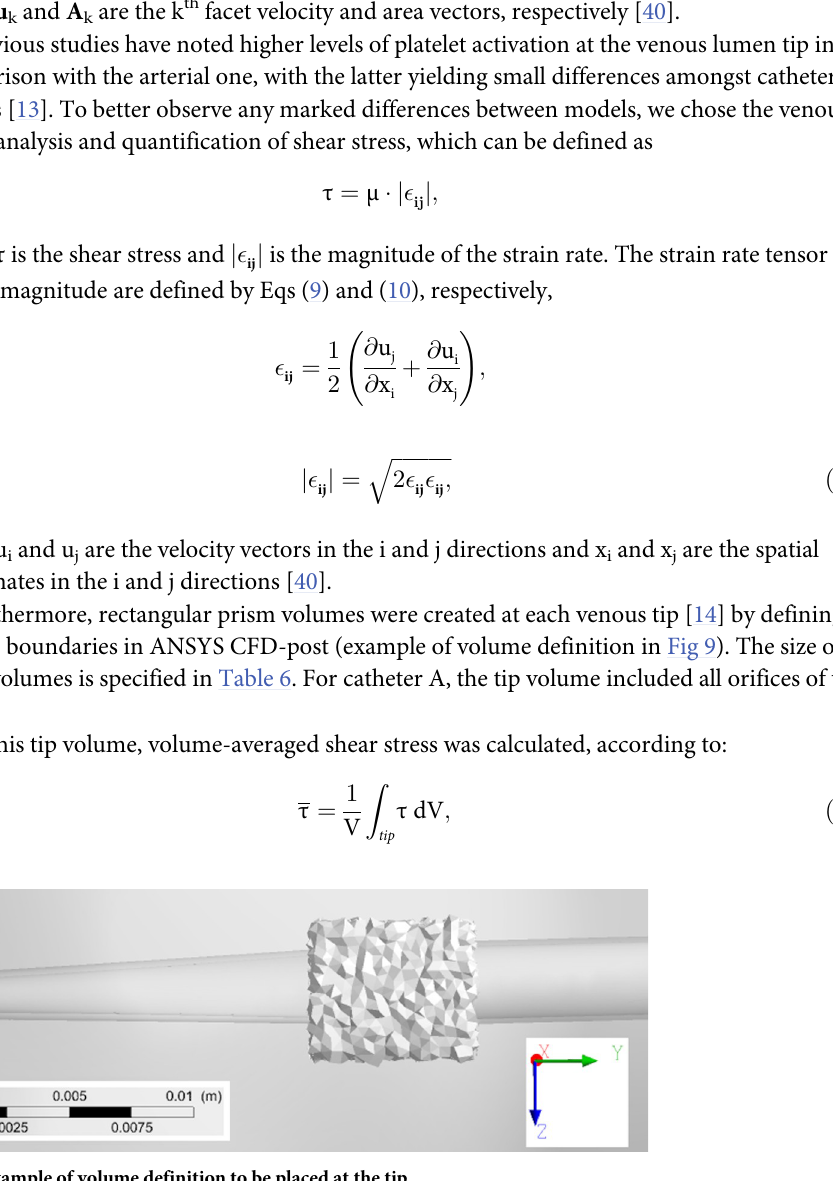
Fig 9. Example of volume definition to be placed at the